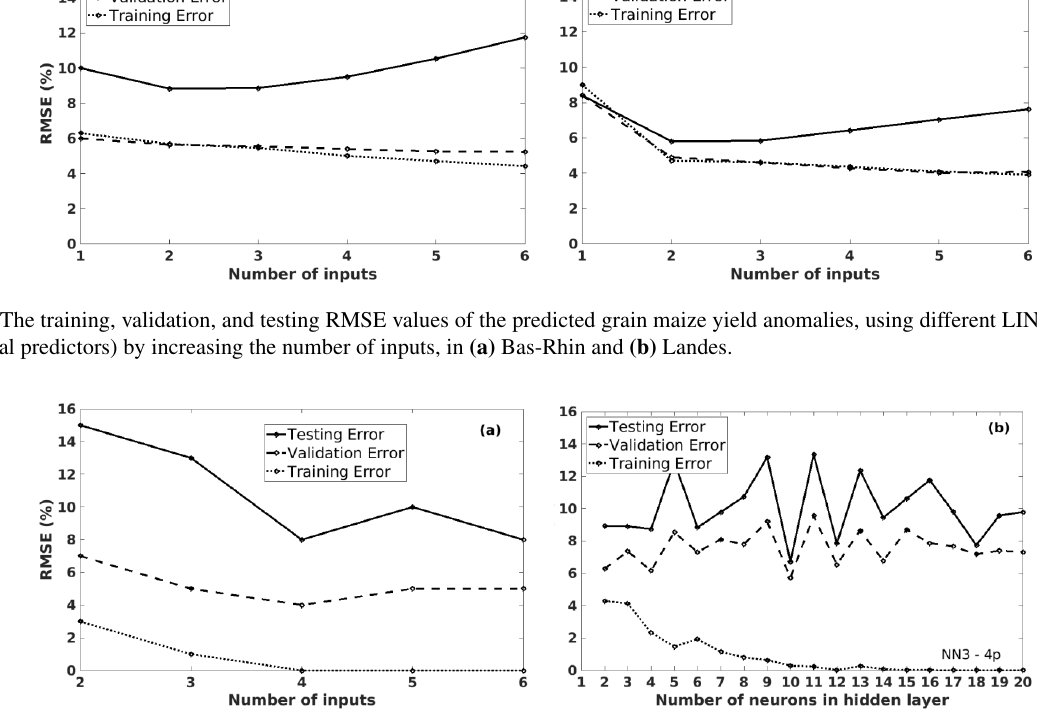
Figure 9. The training, validation, and testing RMSE values of the predicted grain maize yield anomalies, using different NN models with various choices, in Bas-Rhin (France): (a) NN models (with n pre = 12 and n neuron = 7) by increasing the number of inputs; (b) NN3 models (with n pre = 4) by increasing the number of neurons in the hidden